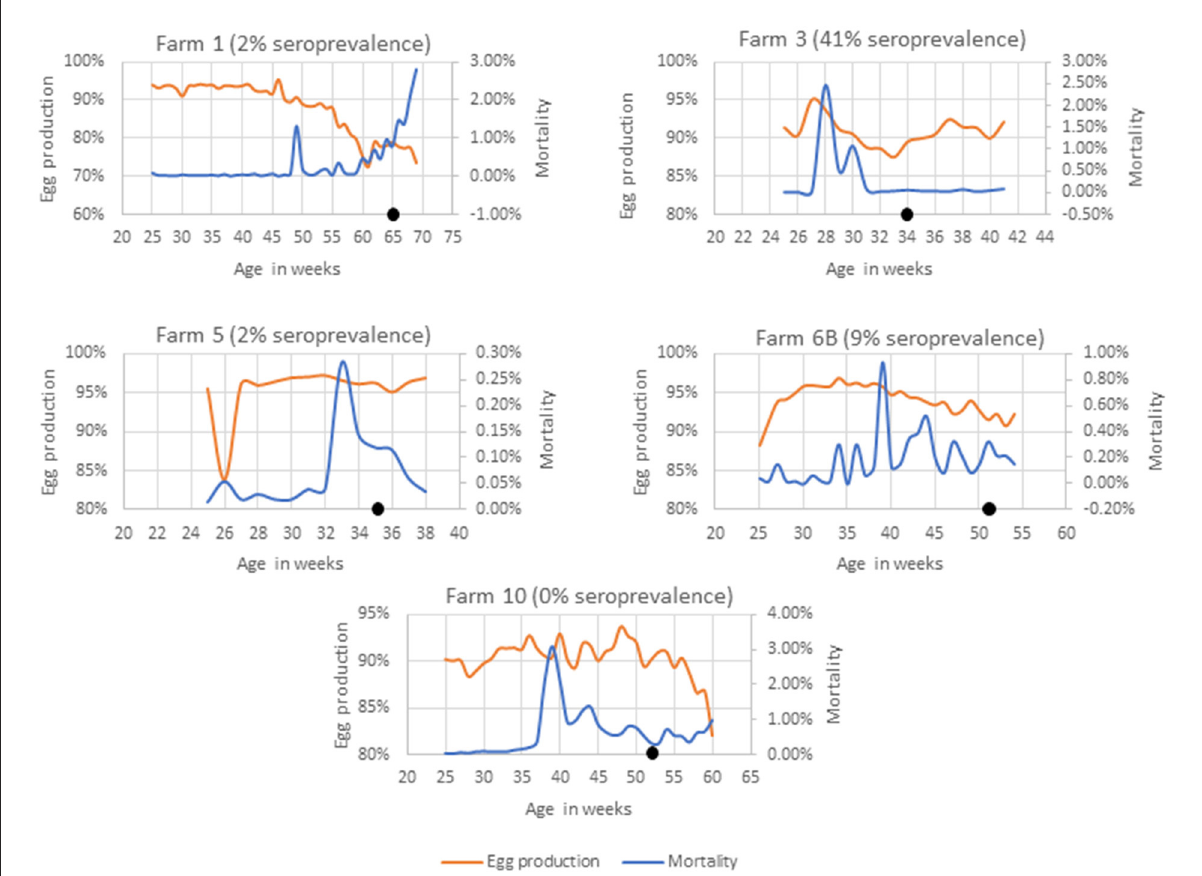
FIGURE1 Mortality and egg production in farms with no known history of SLD. The black dot indicates the week of sample